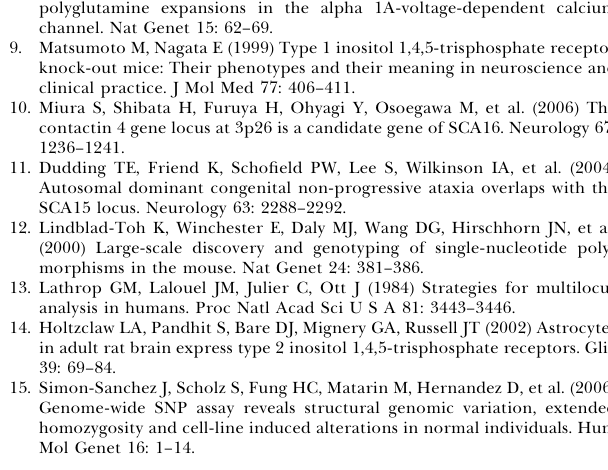
Figure S1. Schematic of Genotyping Results across Mouse Chromo- some 6 in Affected Mice Black squares are indicative of a C57BL/6J homozygous genotype; light grey squares, a 129x1/SvJ homozygous genotype; grey squares, a C57BL/6J 129x1/SvJ heterozygous genotype; white squares, undeter- mined genotype. The black box bounds a region of homozygous 129x1/SvJ genotypes that segregate with disease; thus, the critical region was determined to be between markers D6Mit37 and 44.MMHAP85FLG5. Figure S2. Sequence of Exon 36 of Itpr1 from Four Mice A wild-type homozygous C57BL/6J mouse (A), a wild-type homo- zygous 129x1/SvJ mouse (B), an affected 129x1B6 mice homozygous for the 18-bp deletion mutation (C), and an unaffected mouse heterozygous for the 18-bp deletion mutation (D). The deleted nucleotides are bounded by a green box. Figure S3. Additional Families Harboring Deletion at the SCA15 Locus (A) Family H33; (B) family H27. Upper panel shows log R ratio and B allele frequency metrics generated from Infinium HumanHap550 arrays for an affected family member from each family. Log R ratio is the ratio of normalized, observed R to expected R for each SNP (each SNP is a blue dot) and thus serves as a surrogate of copy number at each locus. B allele frequency is a measure of the number of times the A or B alleles are detected at each locus (each SNP is denoted by a blue dot). Thus, SNPs with a B allele frequency of one are apparent B/ B homozygotes, SNPs with a B allele frequency of 0.5 are apparent A/